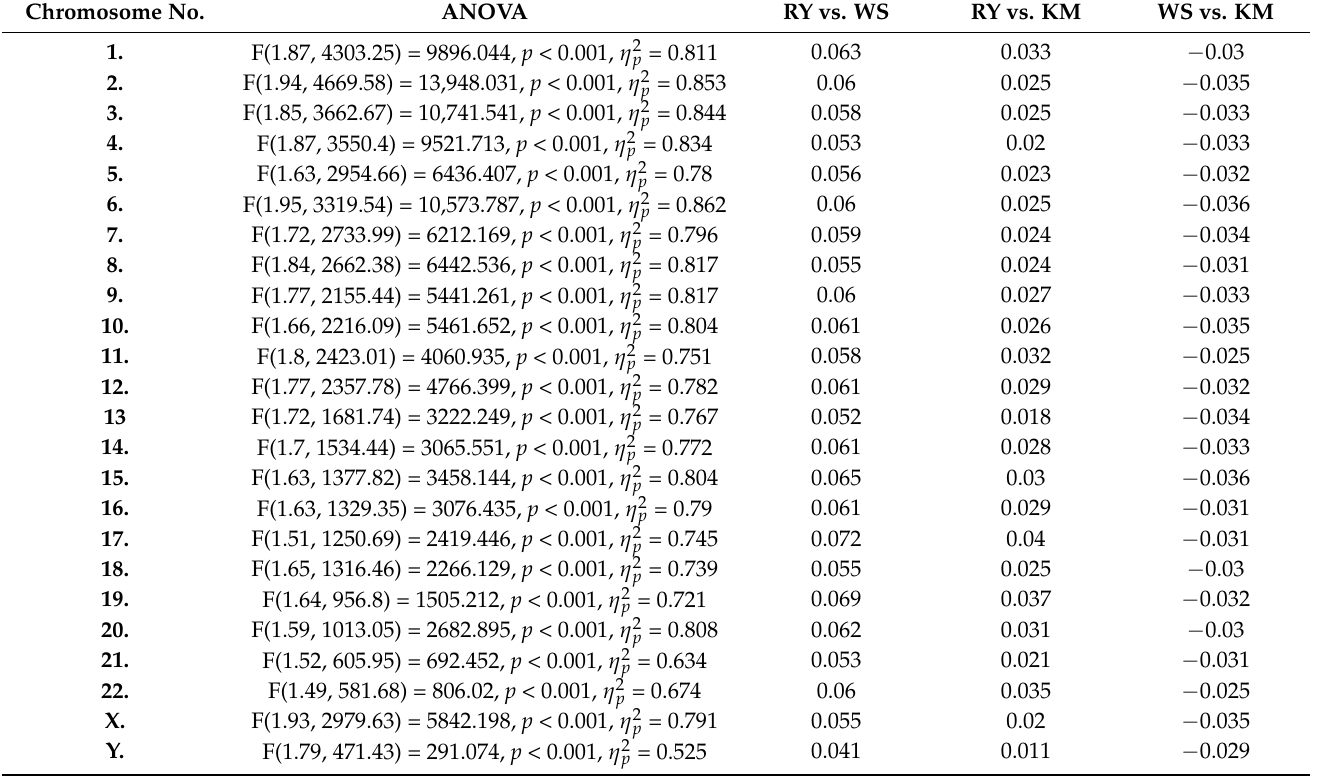
Table A1. Results of the one-way within subject ANOVA and the follow-up pairwise comparisons. Chromosome No.